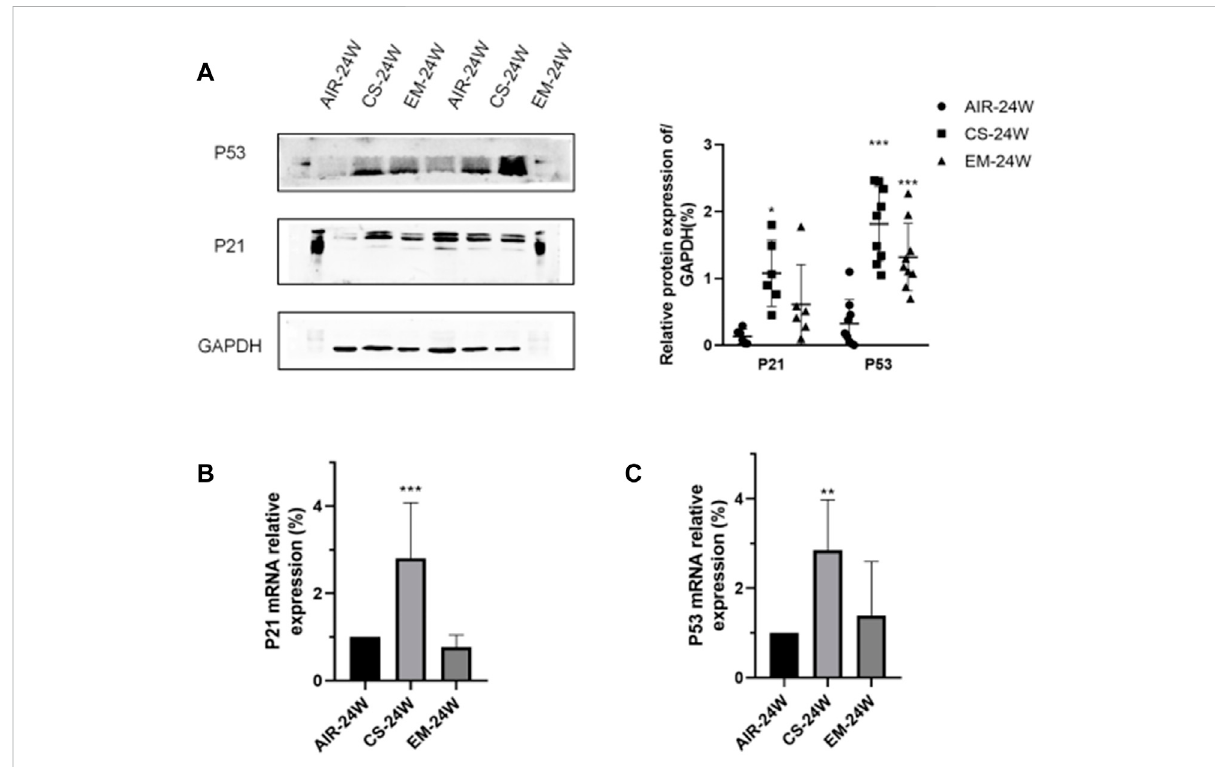
FIGURE 2 Erythromycin inhibited the expression of P53 and P21 in mice with CS-induced emphysema. (A) Protein expression levels of P53 and P21. (B-C) mRNA expression levels of P53 and P21. *** p < 0.0001, ** p <